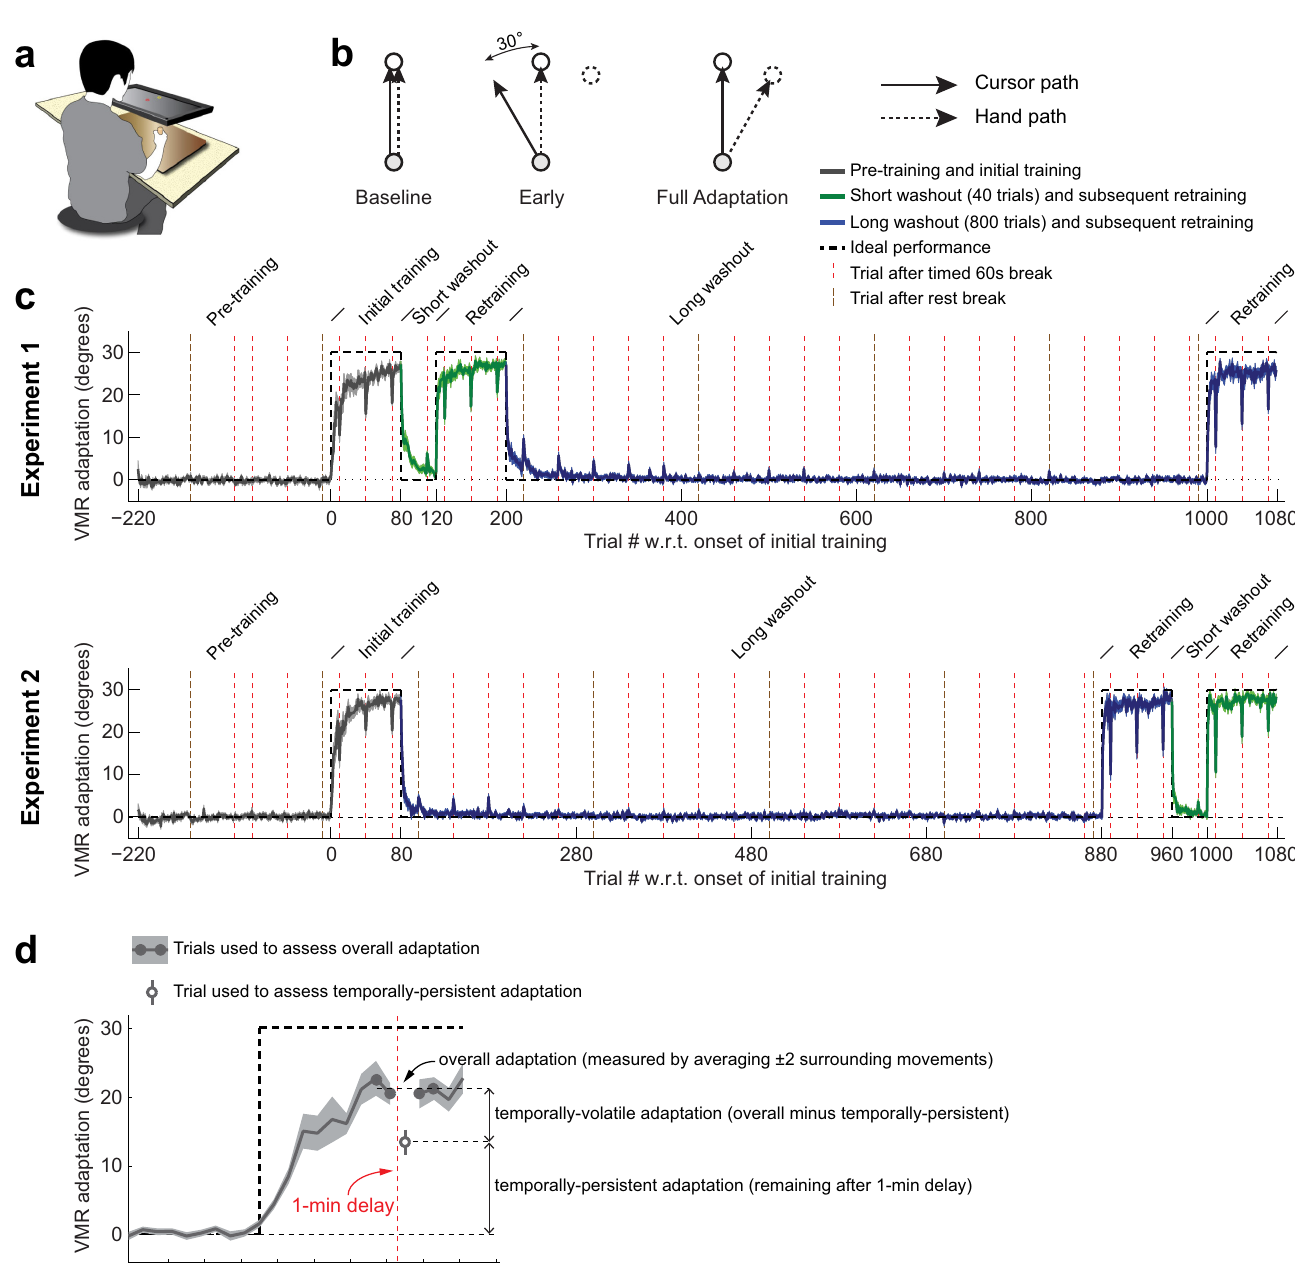
Fig 1. Experiment setup and training paradigm. (a) Experiment setup. Subjects made point-to-point reaching movements on a digitizing tablet and received continuous visual feedback on a screen mounted above it. (b) VMR training. During baseline (left), the cursor follows the hand motion, whereas during training, cursor motion is skewed by 30˚ from the hand motion (in this example, counter-clockwise), resulting in a 30˚ error before adaptation (middle). If full adaptation is achieved, hand motion must completely counter the imposed rotation, corresponding to a 30˚ clockwise hand motion in this example (right). (c) Top: experiment schedule and raw data for Experiment 1. There were 3 phases: a baseline period followed by the initial 80-trial VMR training (average adaptation level shown in gray); a short, 40-trial washout period followed by retraining (green); and a long, 800-trial washout period followed by another 80-trial retraining session (blue). Red dashed vertical lines indicate trials conducted after 60-s delays to isolate temporally-persistent adaptation. Brown dashed vertical lines indicate trials following rest breaks. Note that, during the washout periods, adaptation peaks on these delay and rest break trials, illustrating a slower washout for temporally-persistent vs. temporally- volatile adaptation. Bottom: same but for Experiment 2, where the long, 800-trial washout period came first. Error bars indicate SEM. Underlying data supporting this panel can be found in file Exp_1_2_data.mat. (d) Dissection of adaptation into temporally-persistent and temporally-volatile components. Throughout the experiment, we used 60-s delays to allow temporally-volatile adaptation to decay. The amount of adaptation on the trial following such a delay (open gray circle) was taken as a measure of temporally-persistent adaptation, whereas the average amount of adaptation 2 trials before and 2 trials after this post-delay trial (filled